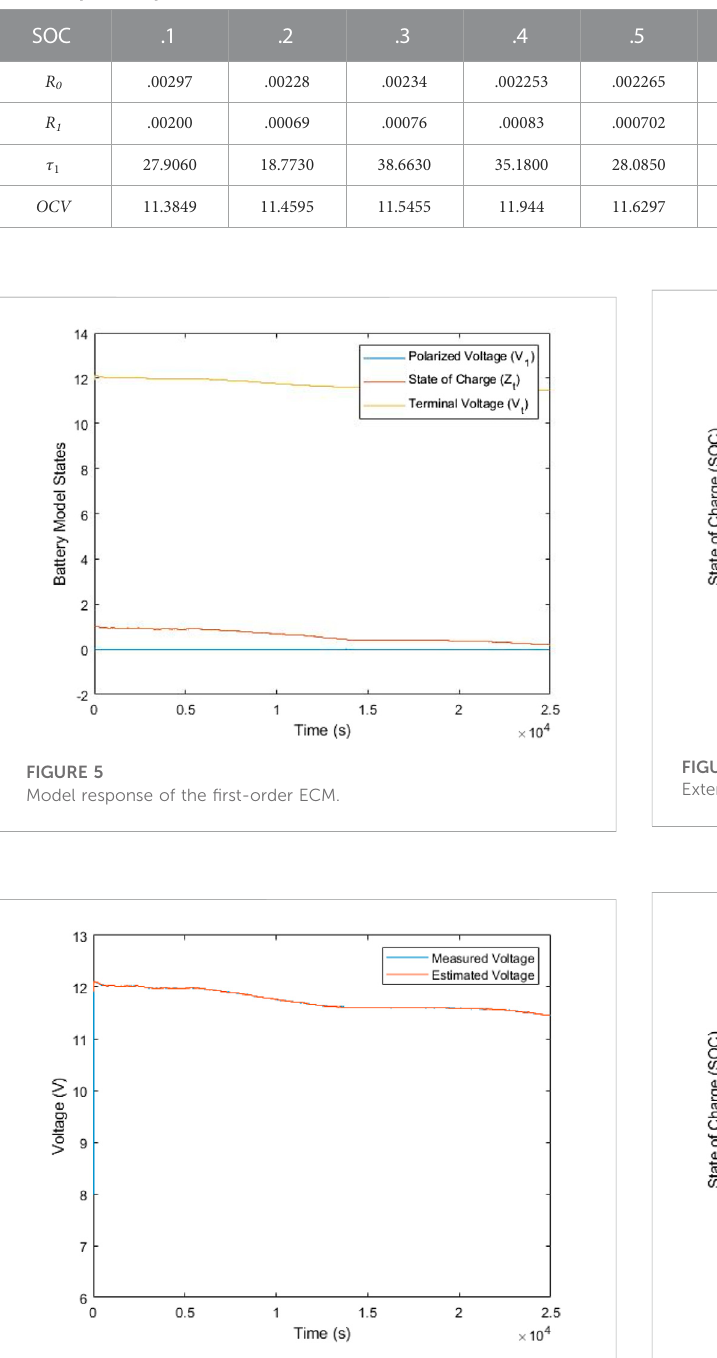
FIGURE 8 Sliding mode observer response.